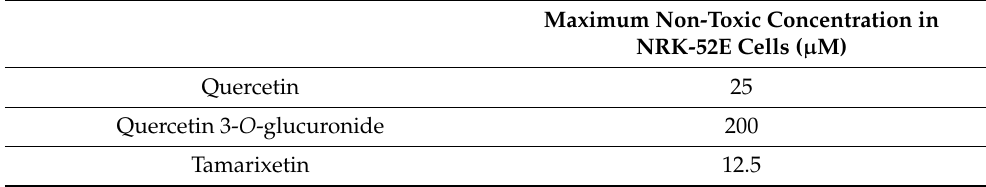
Table 2. Higher non-toxic concentrations of quercetin metabolites in NRK-52E cells. Data were obtained by cell viability assays (MTT assay; Figure S3, Supplementary Material).